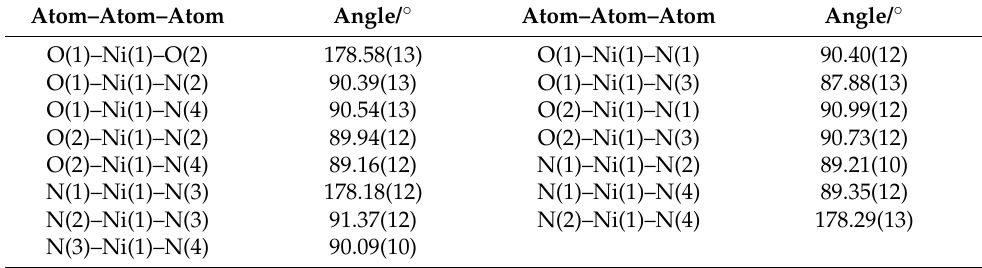
Table 3. Selected angles for 1